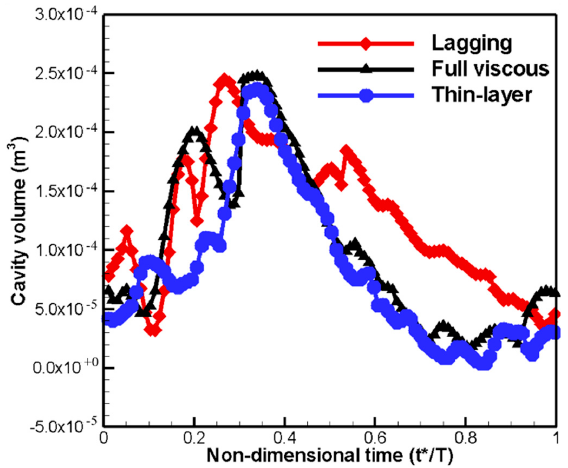
Figure 5. Time-variations of predicted cavity volume of three different viscous flux vector treatment Figure methods.